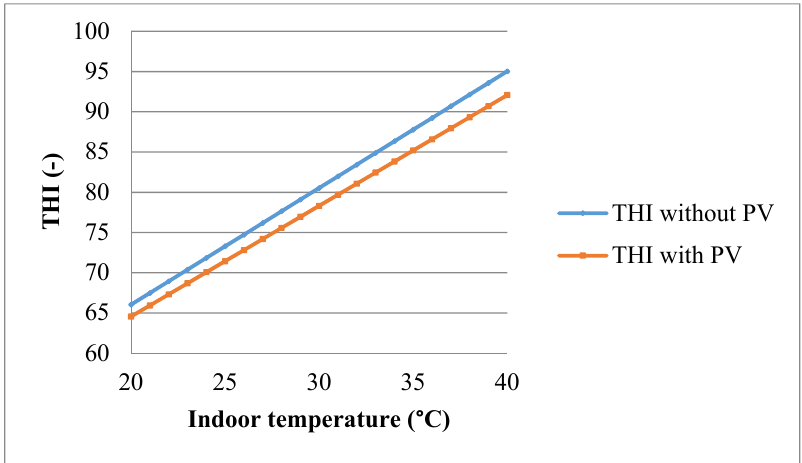
Figure 20. Relations between the THI and the indoor temperature for cowshed with and without installed PV system on the roof.